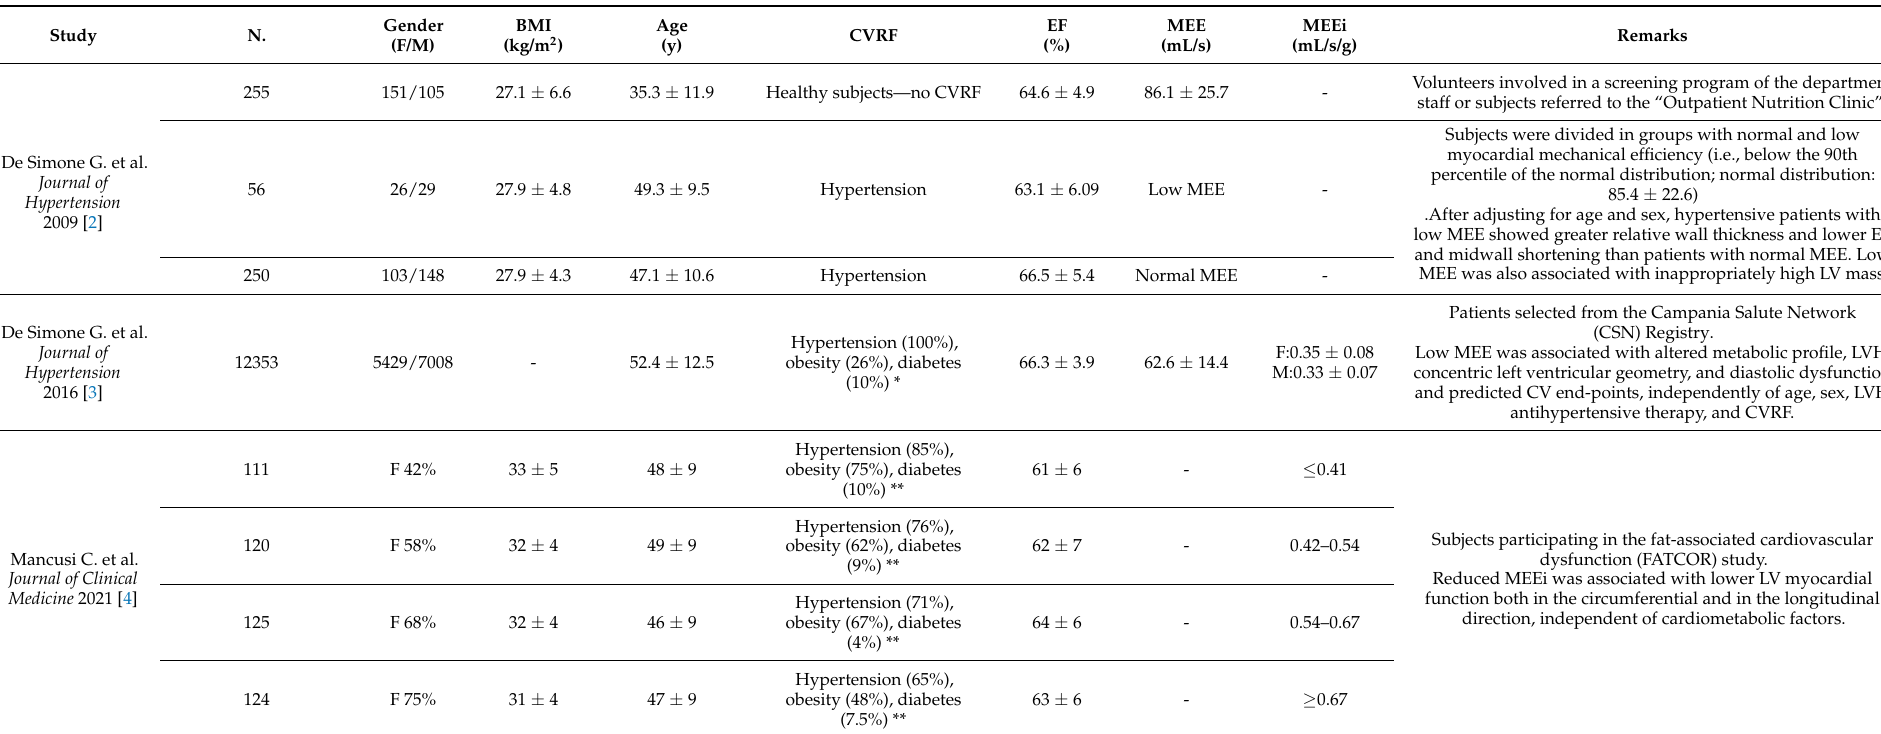
Table 7. Previous studies providing MEE and MEEi values